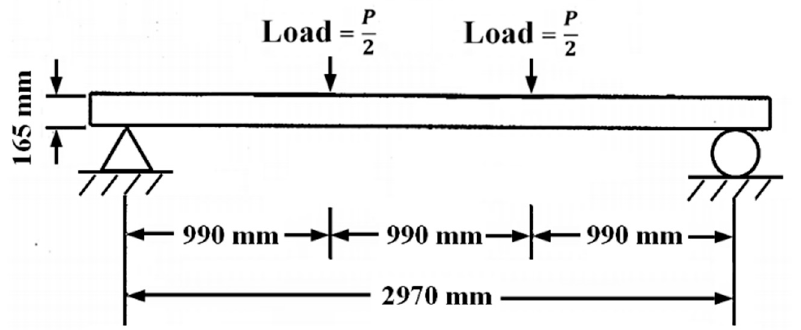
Figure 4. The 4-point bending test scheme.